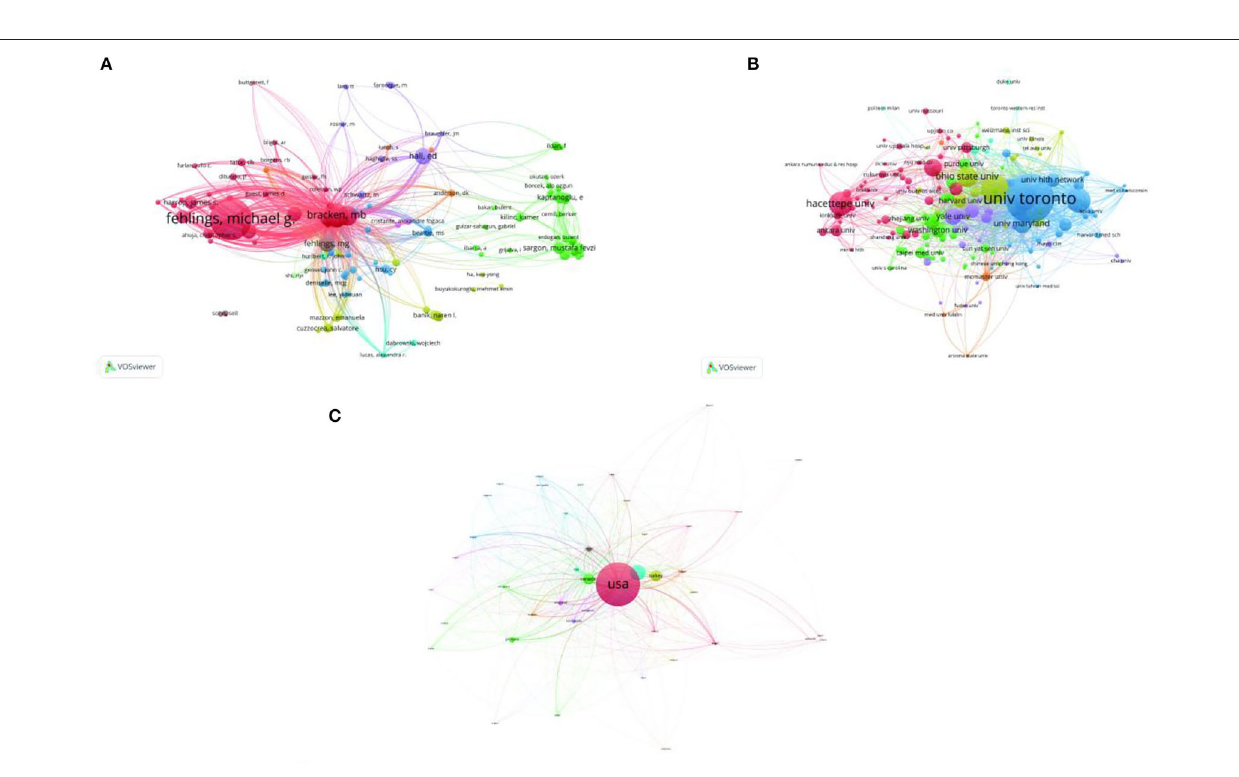
FIGURE 5 | Bibliometric analysis of citations. (A) Mapping on cited authors shows that Michael G Fehlings of the University of Toronto is the most cited author. (B) Among cited institutions, the University of Toronto in the blue cluster is the most cited organization. (C) Mapping on cited countries, the USA is the most cited country in the